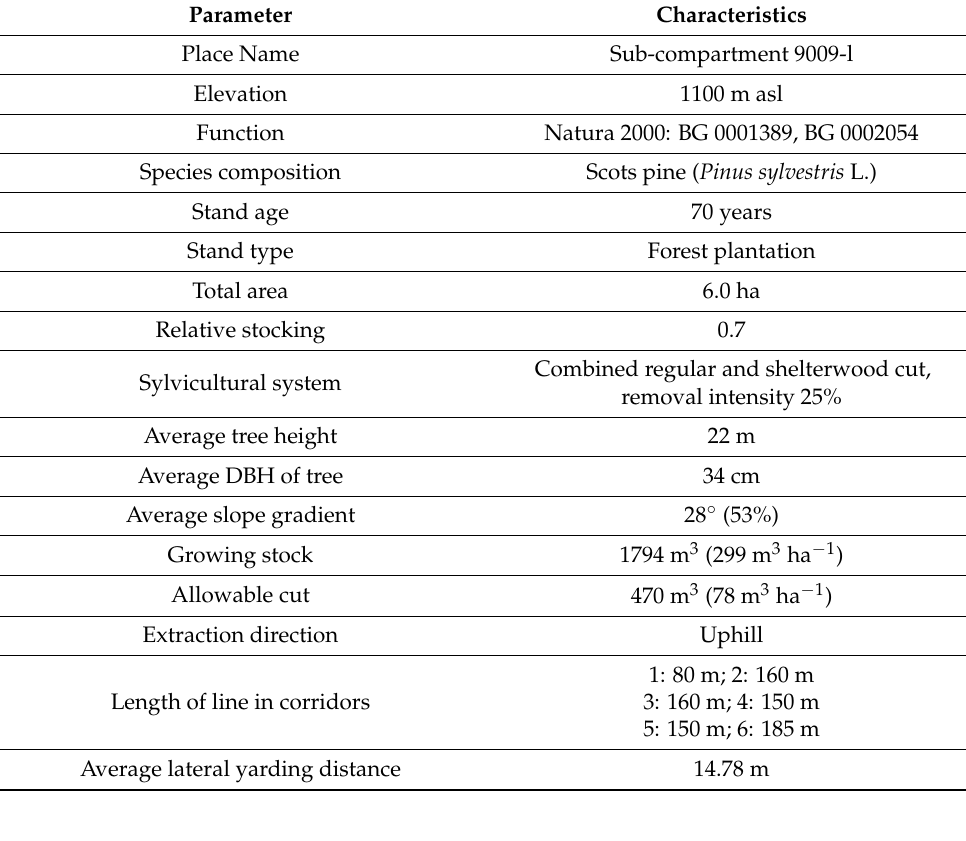
Table 1. Characteristics of the test site.